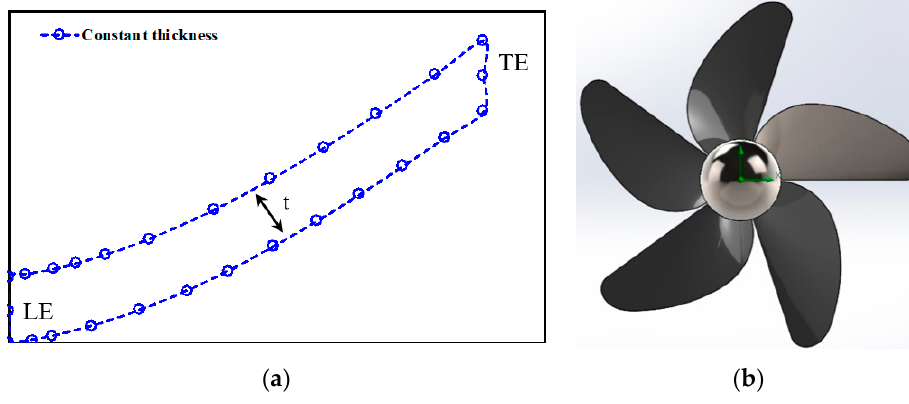
Figure 5. Definition of the blade: ( a ) Definition of 2-D blade profile; ( b ) 3-D CAD model.